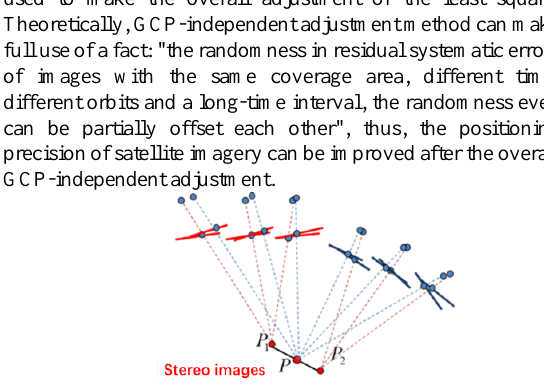
Figure 1: Principle of ground coordinate calculation of virtual "average" control